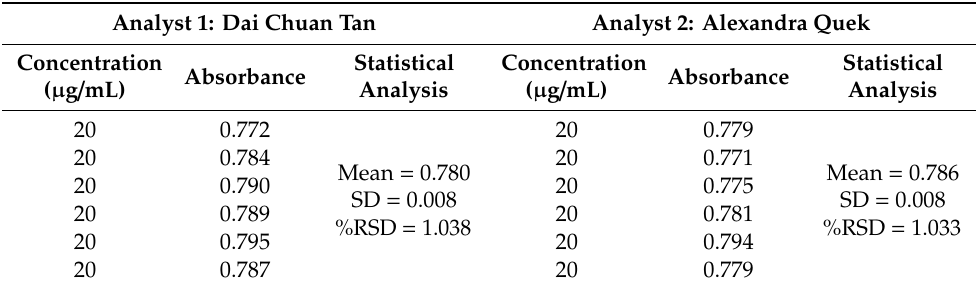
Table 11. Statistical validation for ruggedness studies using UV-vis spectrophotometer.